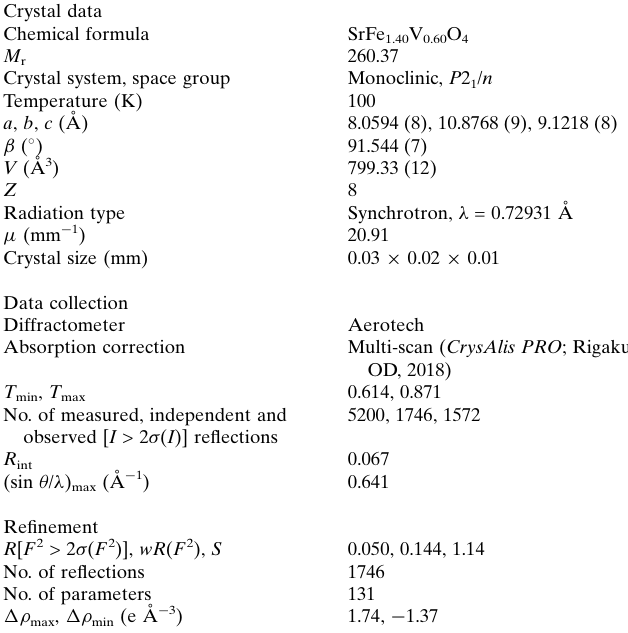
Table 1 Experimental details.